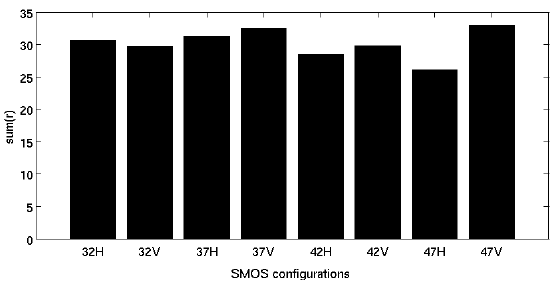
Figure 11. For each SMOS configuration, the sum of the correlation value ( r ) obtained in Figure 8. Only significant stations for all of the SMOS configuration are used for the computation.